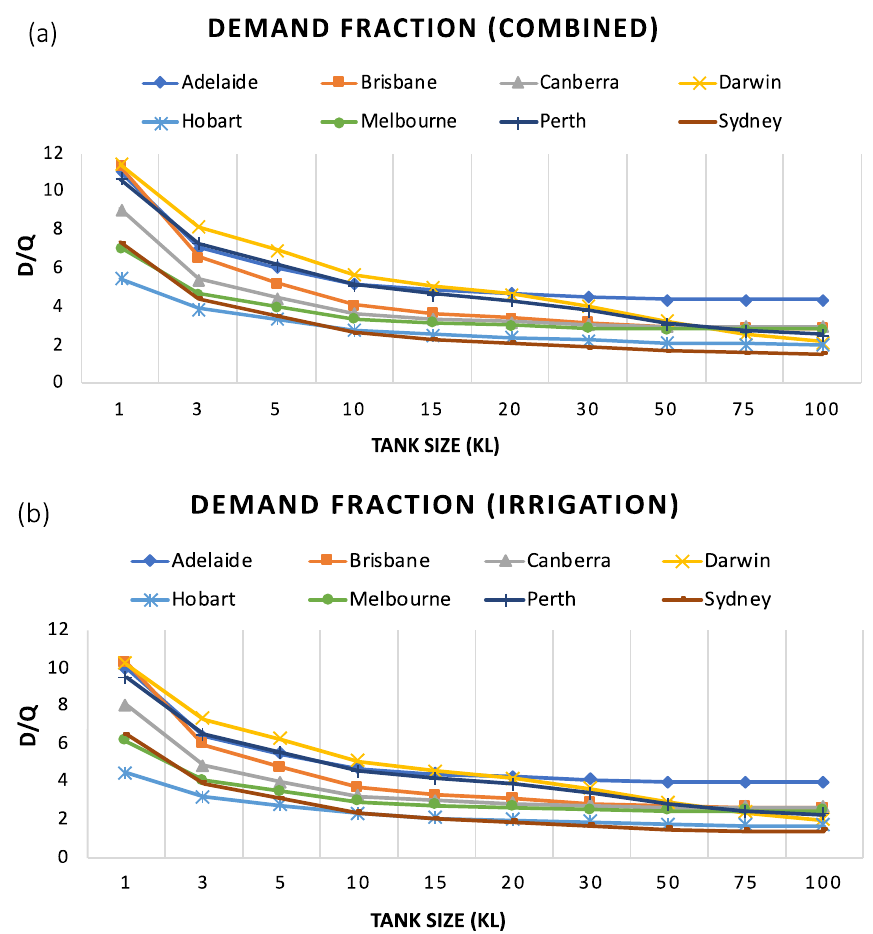
Figure 8. Demand fraction (D/Q) vs . tank size for all eight locations with respect to two water demand types: ( a ) combined use; ( b ) irrigation use.